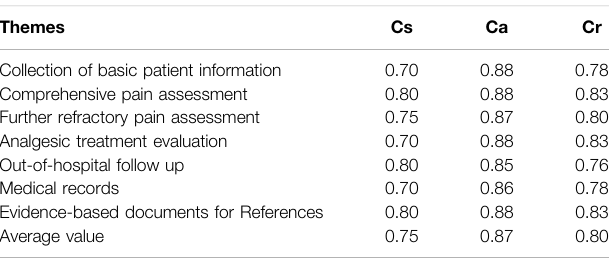
TABLE 4 | Expert authority coef fi cient (Cr) in the fi rst round.